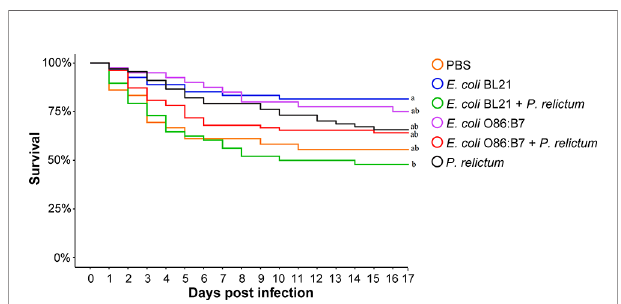
FIGURE 8 | Survival of blood-fed mosquitoes throughout the experiment. The highest mortality was observed in the mosquito group fed on donors vaccinated with E. coli BL21 and infected with P. relictum , which signi fi cantly differed from the group fed on the birds vaccinated with E. coli BL21 ( p = 0.02). Survival of mosquitoes between other groups did not differ signi fi cantly. Survival of mosquitoes was estimated by Fisher ’ s exact test with Bonferroni